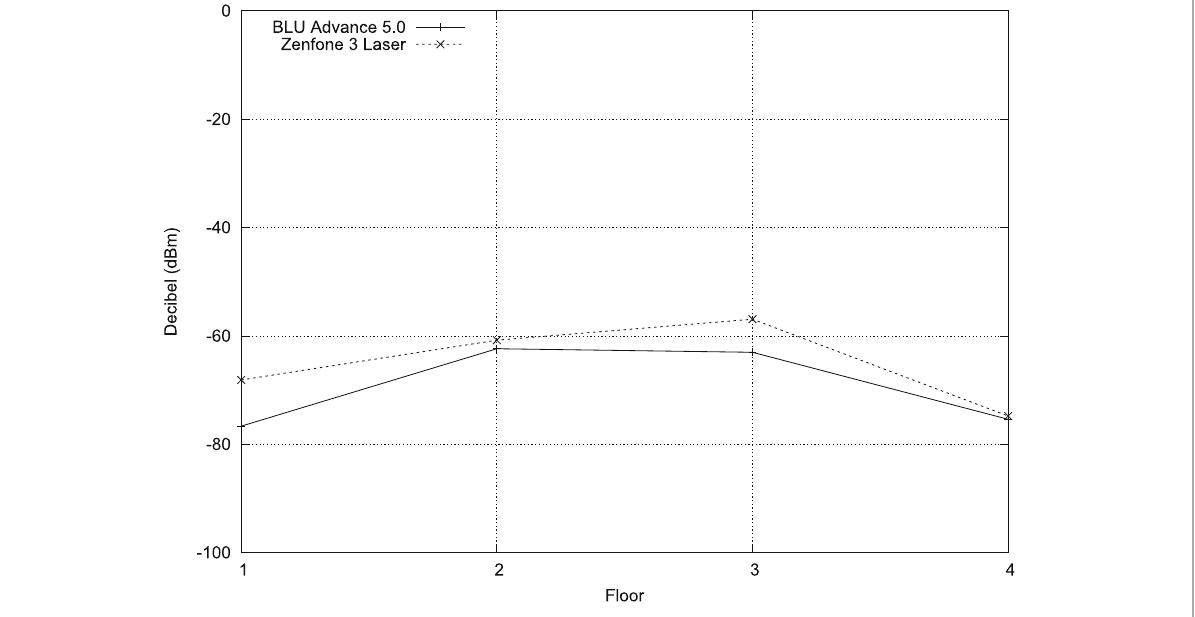
Fig. 12 RSSI comparison: airport time